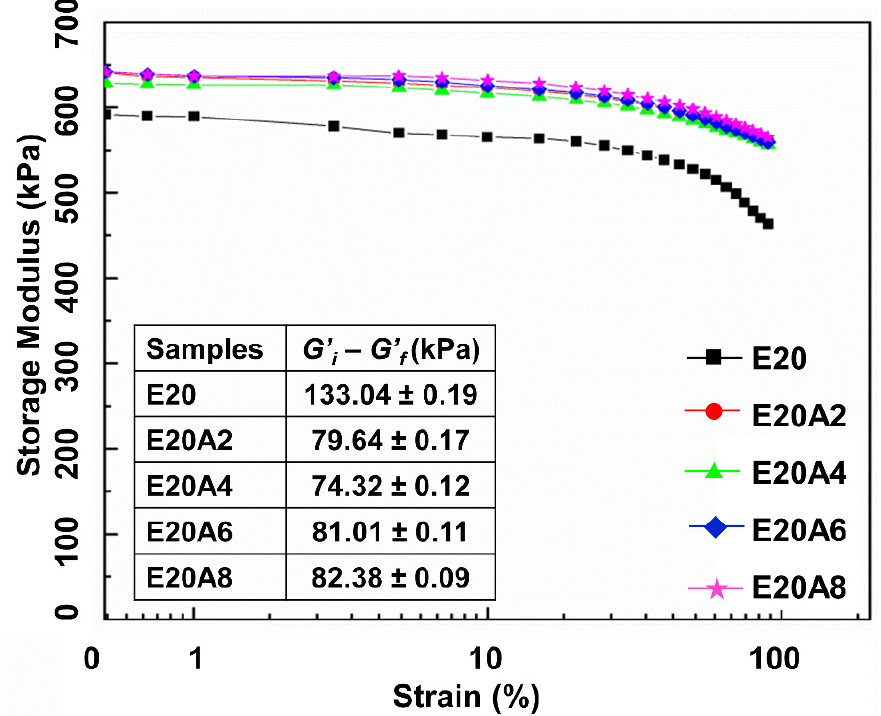
Figure 8. Strain dependence of storage modulus and delta G’ for ENR/HNT composites filled with untreated and acid-treated HNT.